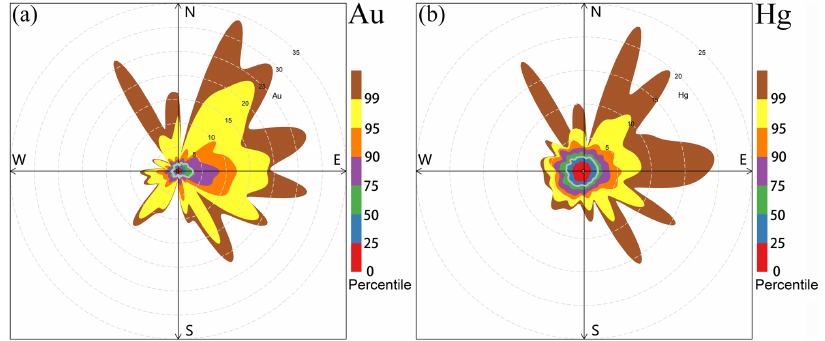
Figure 6. Percentile rose plot of Au (a) and Hg (b) concentrations in Shanghai between March 2016 and February 2017. The percentile intervals are shaded and shown by wind